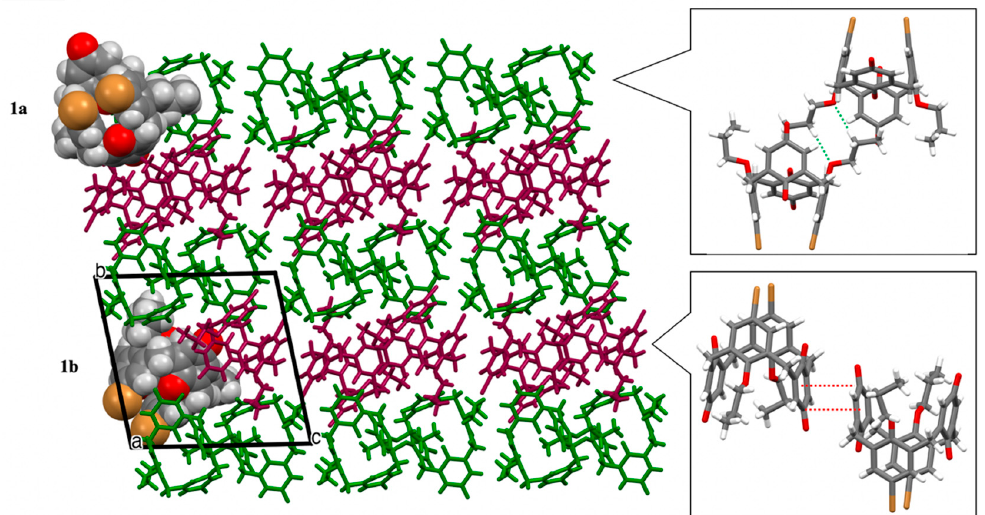
Figure 5. Packing of 1 viewed along the a -axis direction, showing alternating layers of conformers 1a (green) and 1b (maroon). Inset: The intermolecular interactions of adjacent calixarenes within the layers of conformers 1a and 1b .